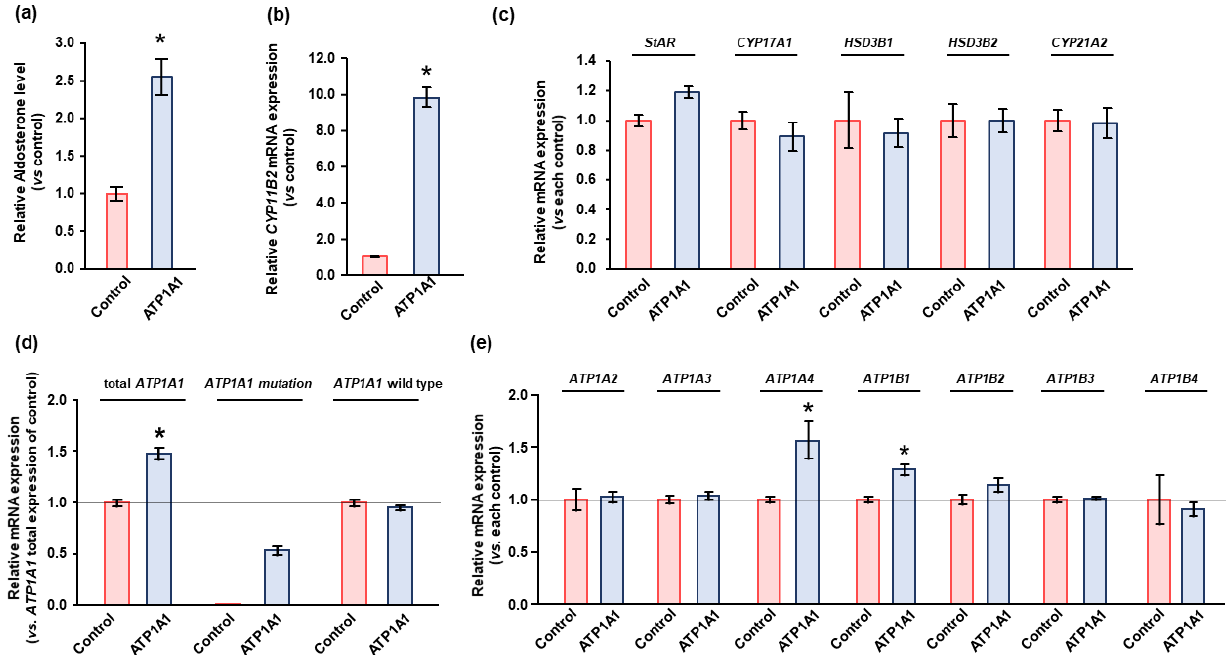
Figure 3. Effect of ATP1A1 L104R mutation on aldosterone production and genes related with Na/K-ATPase (NKA) in HAC15 cells. ( a , b ) After transduction of ATP1A1 mutant ( n = 3) or control ( n = 3) in HAC15 cells and attainment of confluency on 24-well plates, cells were serum deprived in DMEM/F12 containing 0.1% serum for 24 h. Cells were incubated with fresh media with 0.1% serum for 24 h. Aldosterone levels of the supernatant and CYP11B2 expression in the cells were measured. *, p < 0.05 vs. control cells. ( c-e ) After transduction of ATP1A1 mutation ( n = 3) or control ( n = 3) and incubation with DMEM-F12 containing 0.1% cosmic calf serum on 24-well plates for 24 h. Total RNA was extracted, and RNA sequencing analysis was performed. mRNA levels of steroidogenic enzymes were determined as relative expression of each control. Total ATP1A1 , ATP1A1 mutation, and ATP1A1 wild type expression levels were determined as relative expression of total ATP1A1 in control cells. *, p < 0.05 vs. total ATP1A1 expression of control cells. Gene expression levels of NAK subfamily were also measured by RNA sequencing analysis. *, p < 0.05 vs. each control cells.